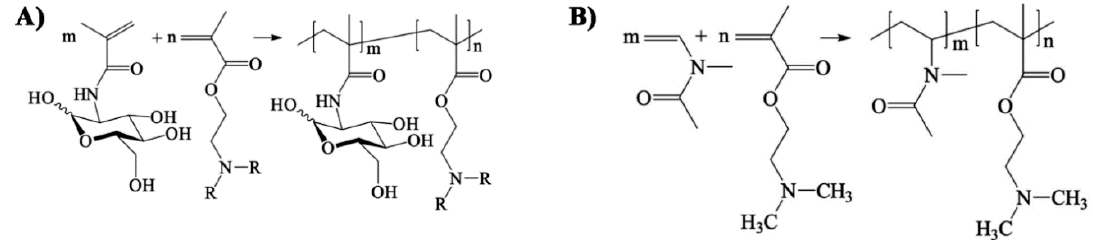
Figure 14. ( A )—Synthesis of co-polymers by reacting 2-deoxy-2-methacrylamido- d -glucose and DMAEM (R = CH 3 ) or DEAEM (R = C 2 H 5 ); ( B )—Synthesis of co-polymer by reacting N -vinyl- N -methylacetamide and DMAEM. Reprinted by permission from Springer, Nazarova O V., Anan’eva EP, Zarubaev V V., Sinegubova EO, Zolotova YI, Bezrukova MA, et al. Synthesis and Antibacterial and Antiviral Properties of Silver Nanocomposites Based on Water-Soluble 2-Dialkylaminoethyl Methacrylate Copolymers.